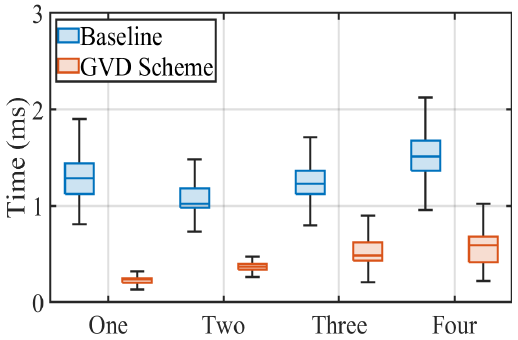
Figure 11. RoI extraction performance under variable LED